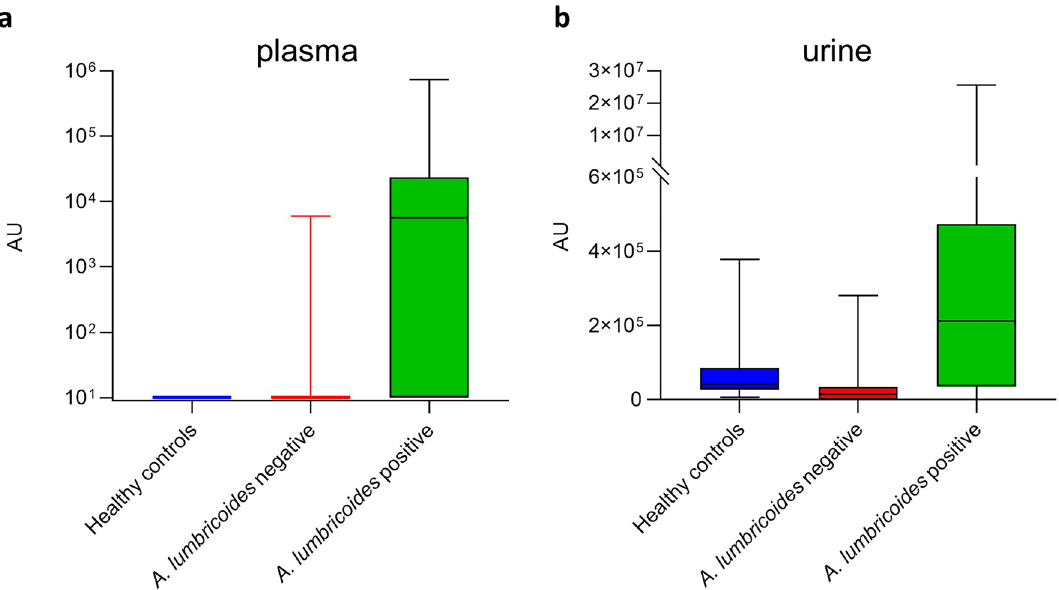
Figure 1. Discovery of an Ascaris lumbricoides specific biomarker. Box-and-whisker plots of the identified feature in plasma ( a ) and urine ( b ) of A. lumbricoides -positive (green, n = 38) subjects, endemic controls (red, n = 118) and healthy Belgian controls (blue, n = 40). AU = arbitrary units (intensity of ion current measured by the